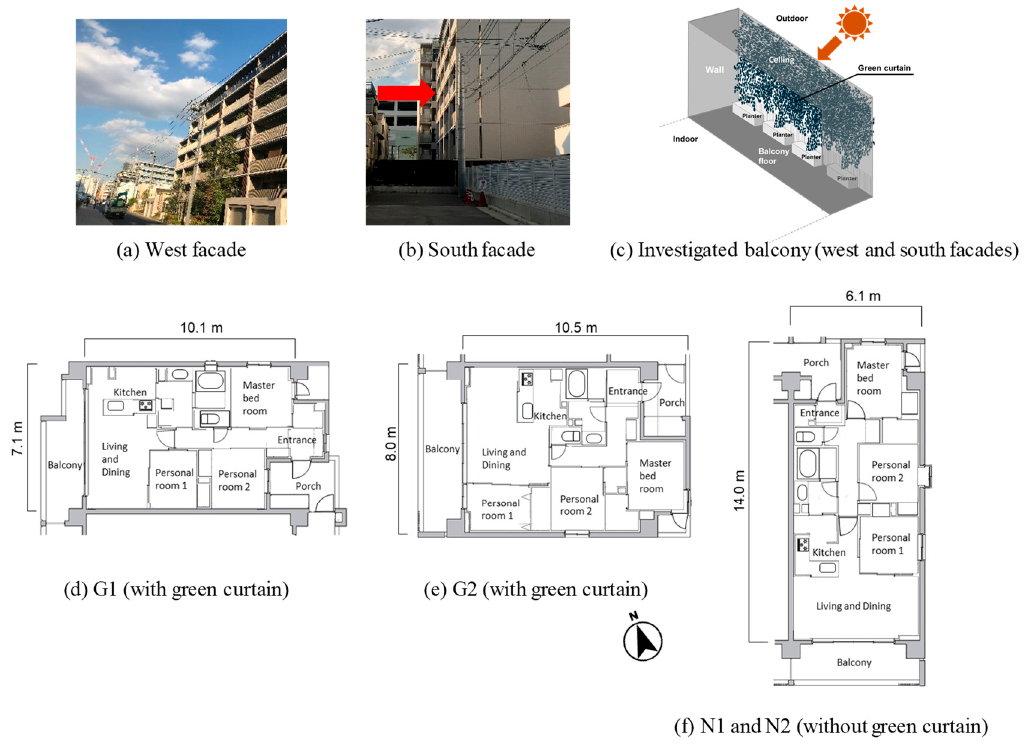
Figure 6. Investigated condominium, balcony, and floor plans.